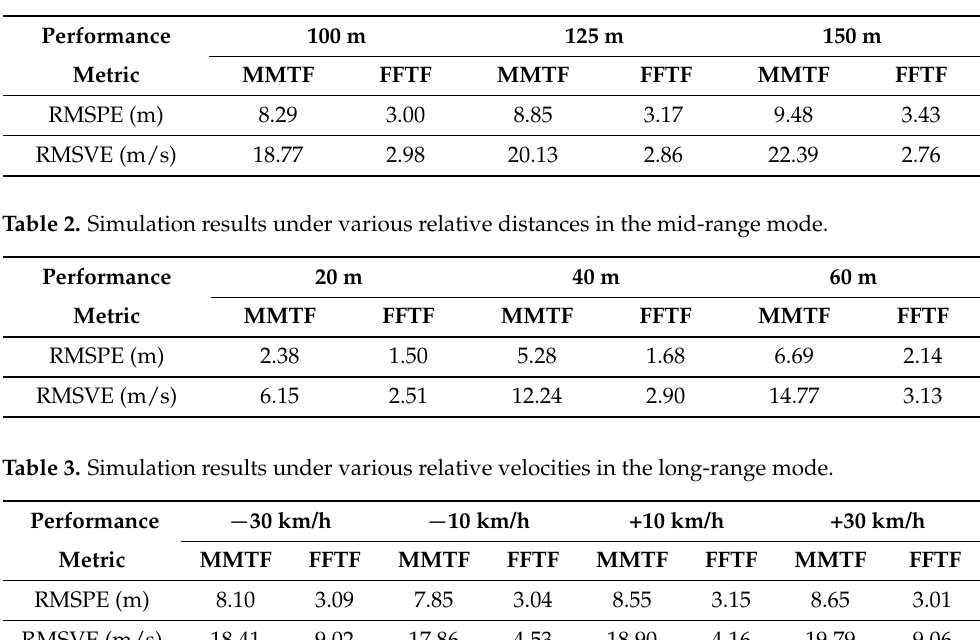
Table 1. Simulation results under various relative distances in the long-range mode.